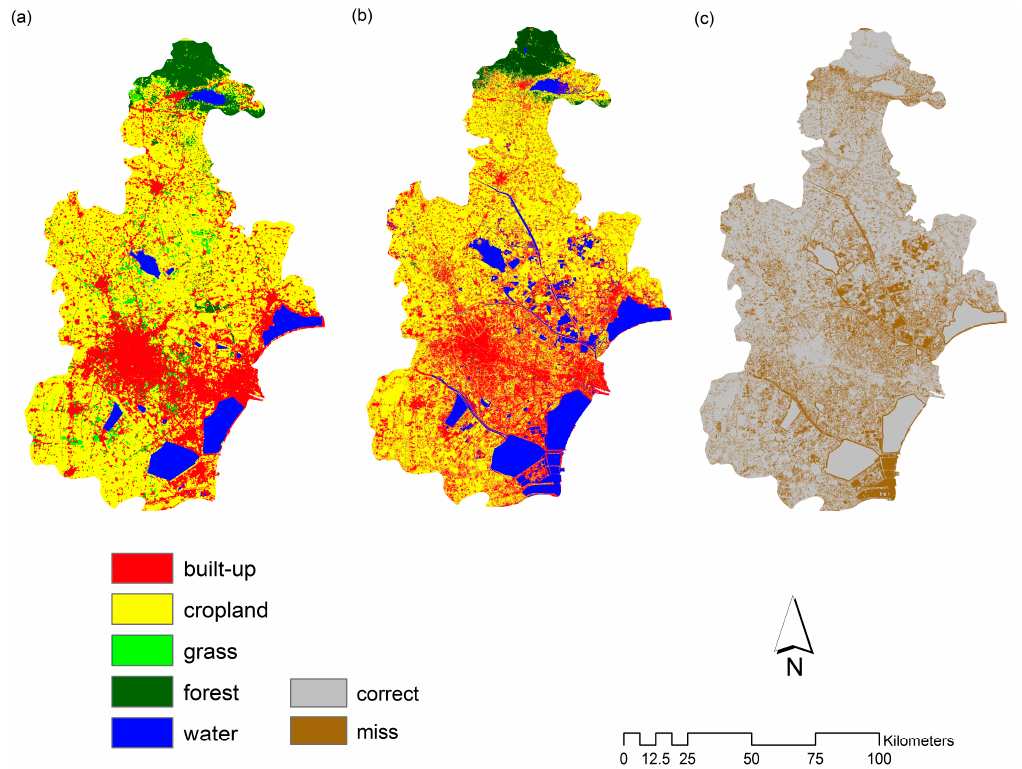
Figure 5. Actual map in 2015 ( a ), simulation map in 2015 ( b ), and error map ( c ).